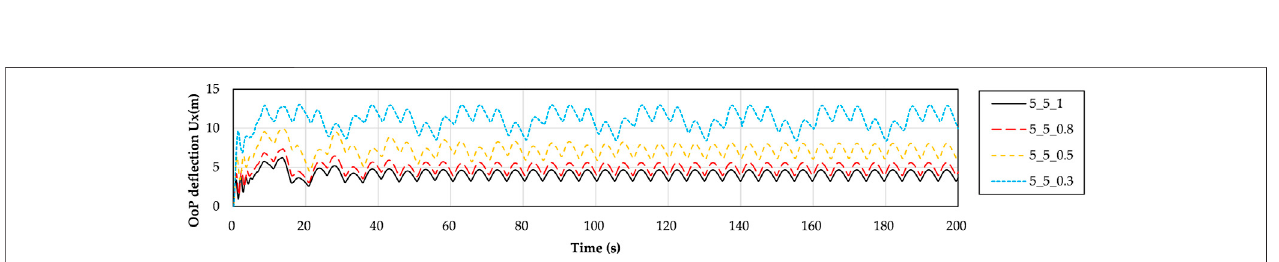
FIGURE 4 | Comparison of effects of fl ap-wise stiffness on tip out-of-plane displacement.